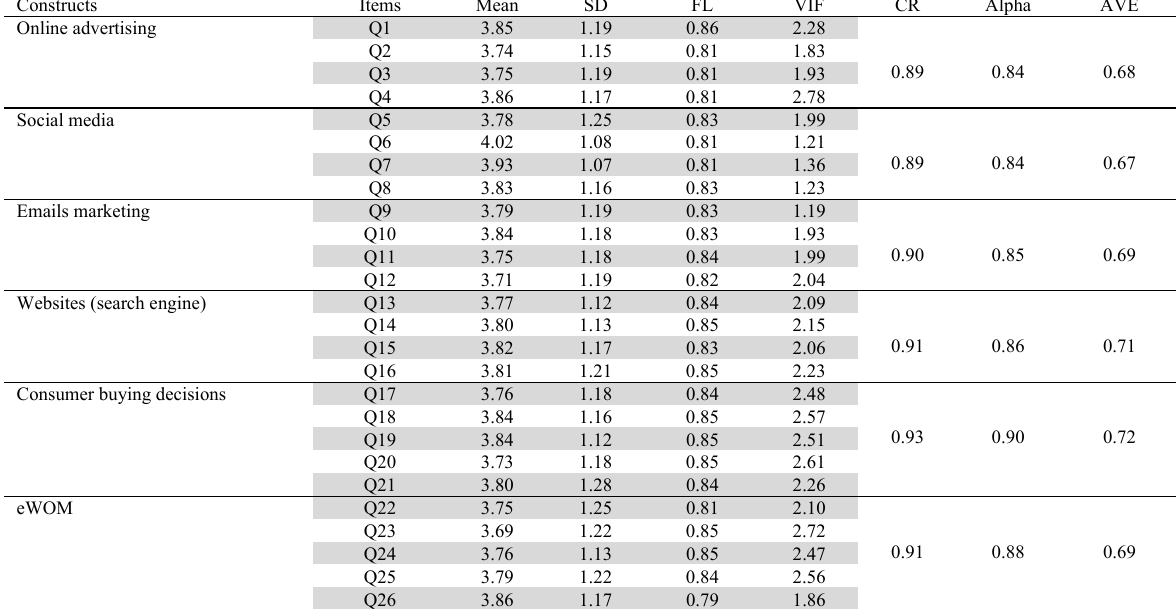
Descriptive Statistics, Validity, & Reliability